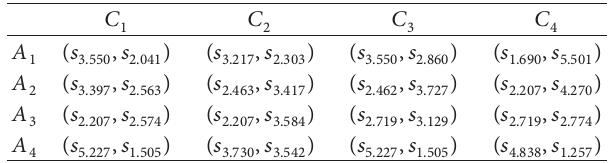
Table 2: The decision matrix 𝑅 2 given by 𝐷 2 .